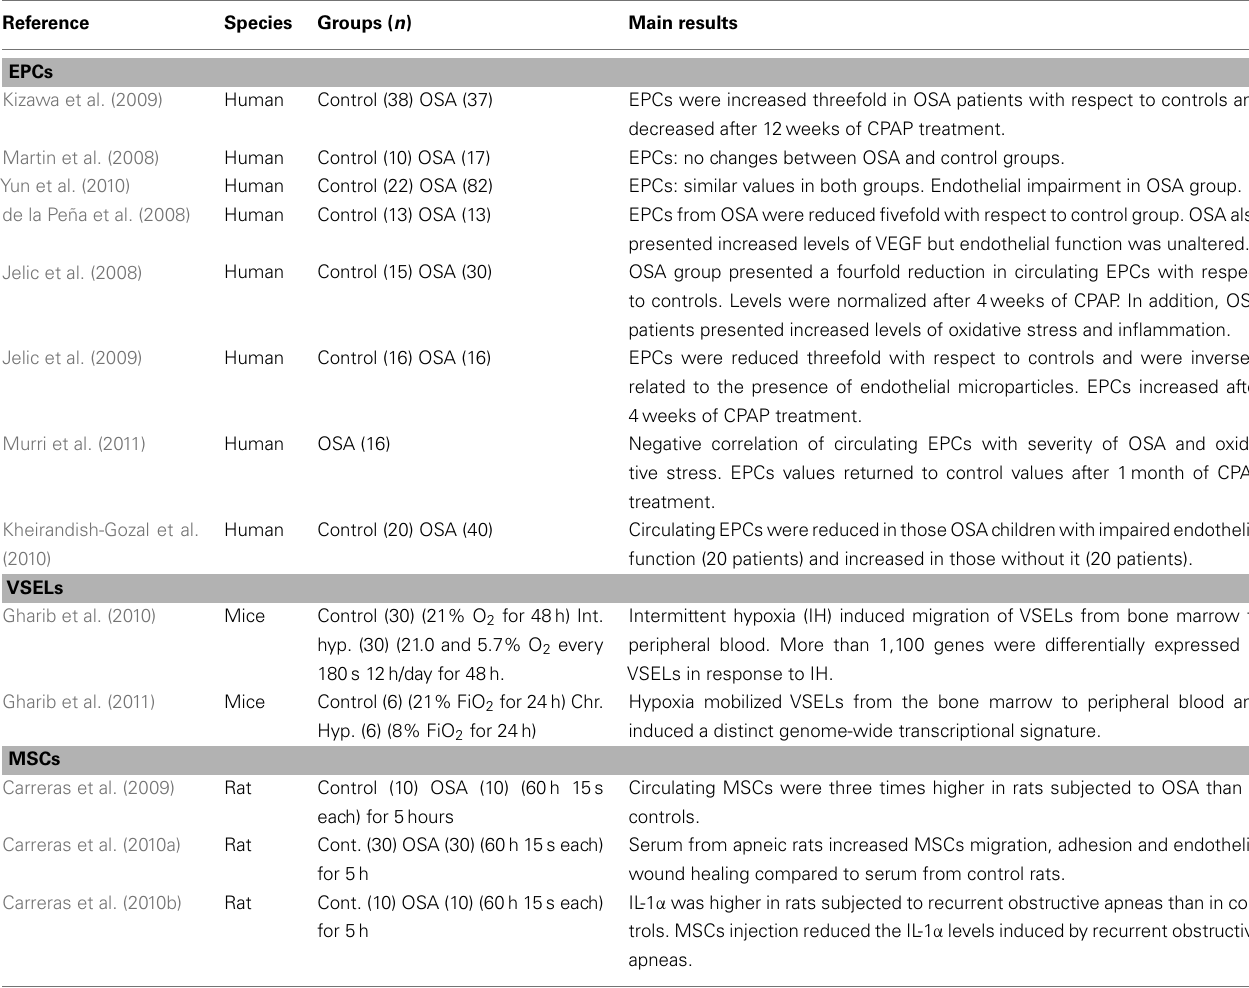
Table 1 | Bone marrow-derived stem cell studies in patients with obstructive sleep apnea (OSA) and animal